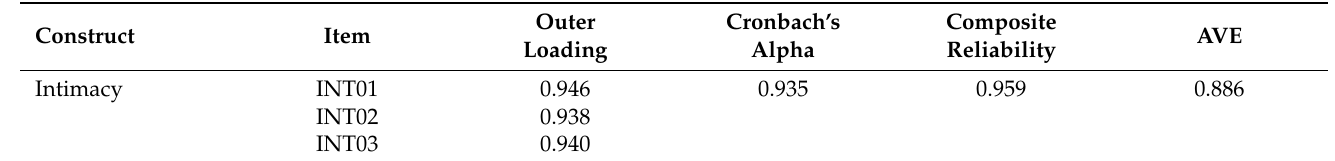
Table A1. Construct Validity and Reliability of Full Sample (N =